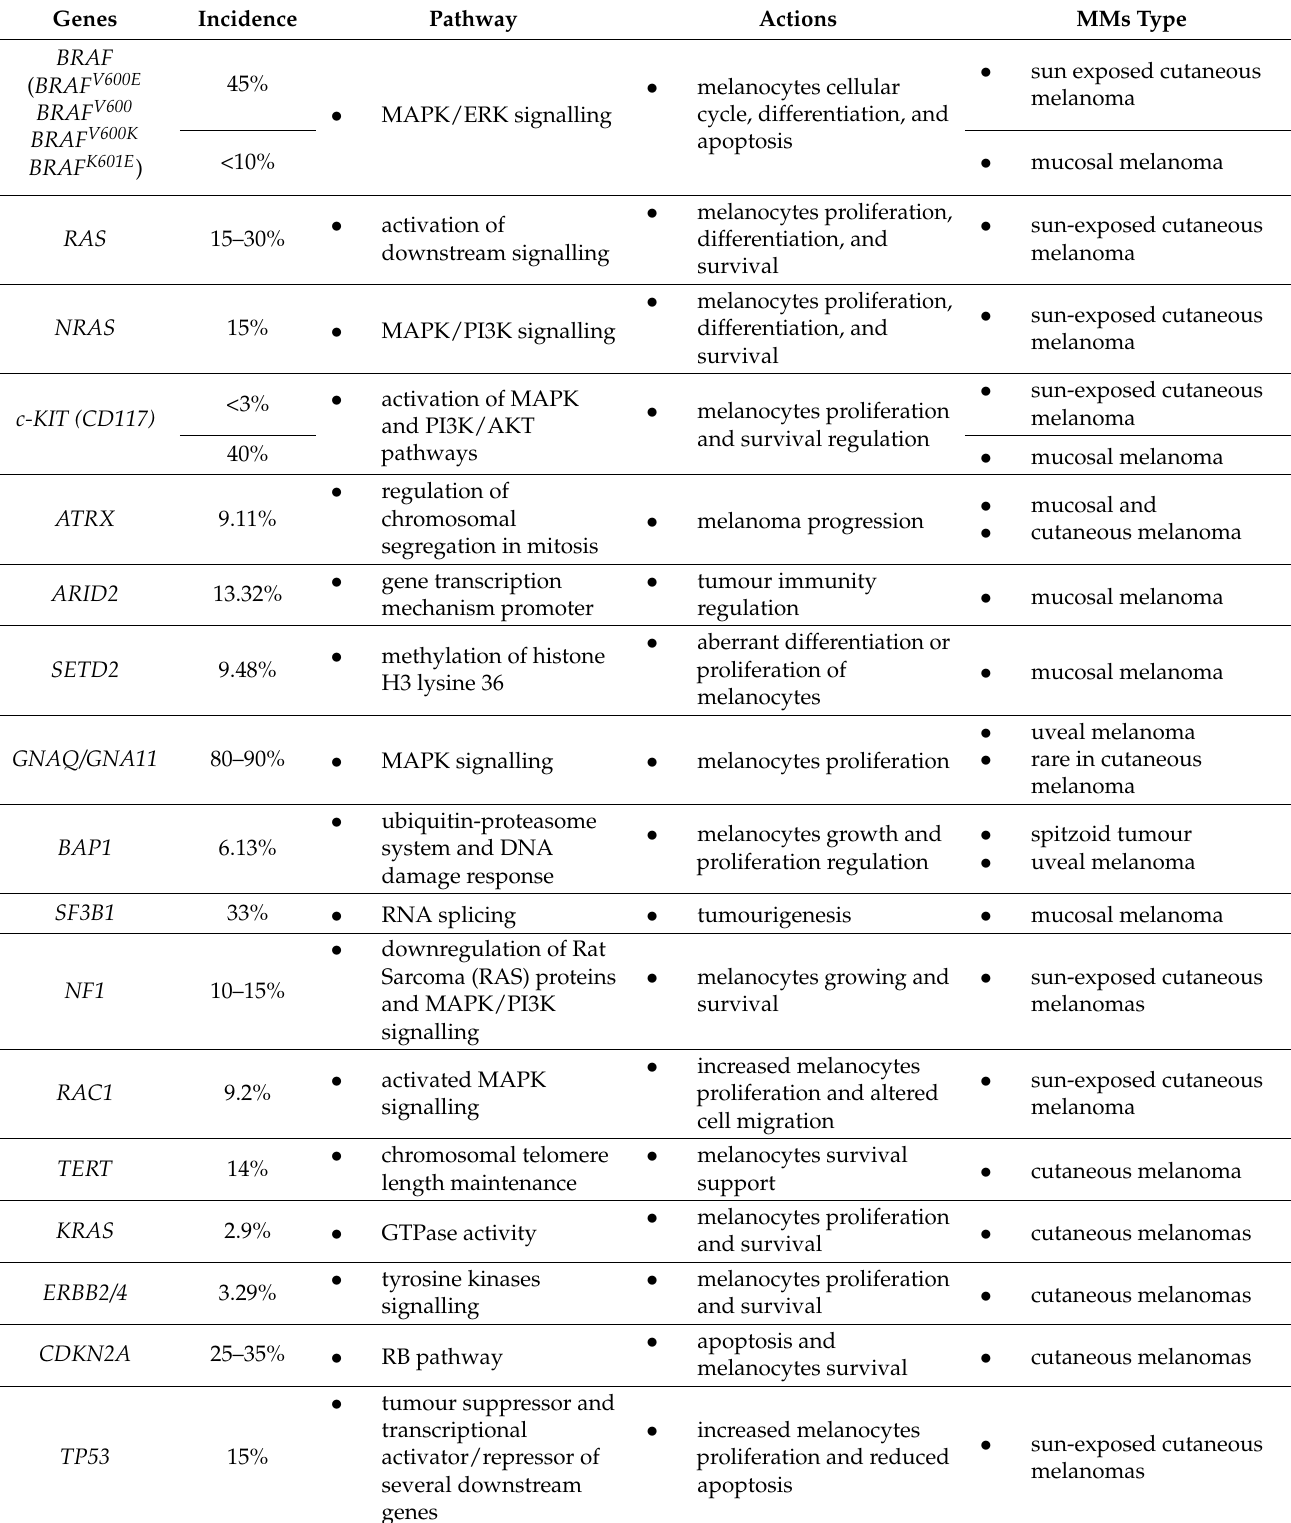
Table 3. Main genomic alterations in malignant